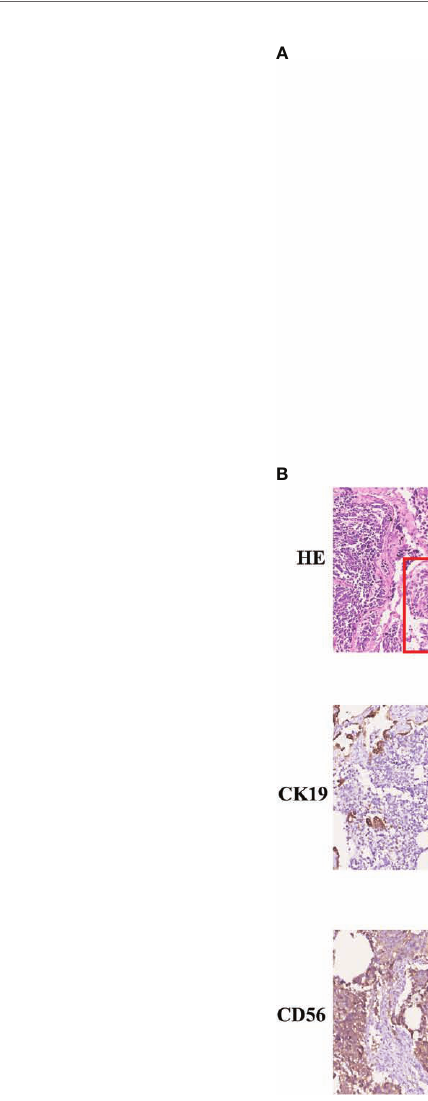
FIGURE 2 | Immunohistochemistry staining of the SCLC and LCNEC regions. (A) H&E staining (400×); (B) immunohistochemistry staining of KI67, CK19, TFF1, CD56, and SYN (200×). The large-cell components were labeled within the red box.